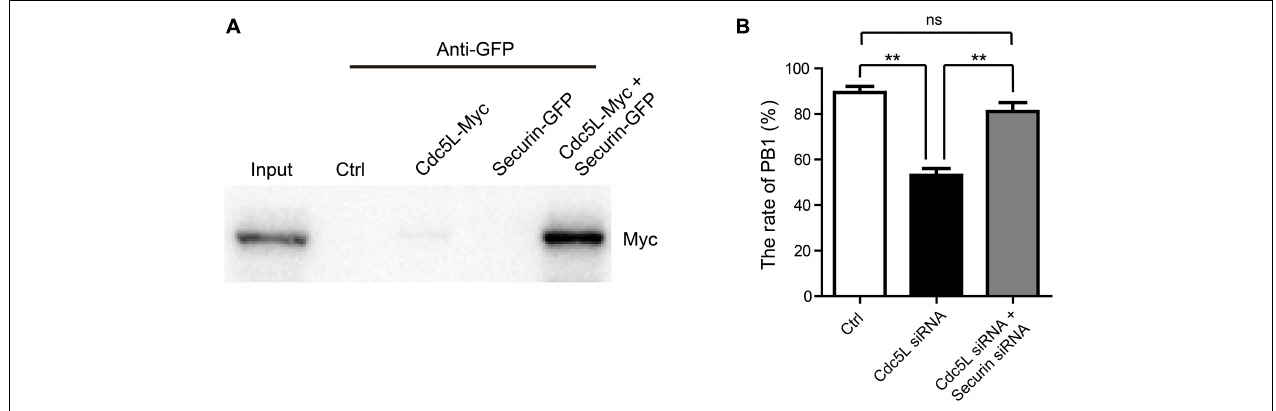
FIGURE 6 | Cdc5L affects metaphase–anaphase I transition by acting through securin. (A) Representation of IP showing interaction between Cdc5L and securin. IP of EGFP-securin was performed with anti-GFP antibody, and precipitates were analyzed by Western blot using an anti-Myc antibody. Myc-Cdc5L and EGFP-securin were co-expressed in 293T cells (lane 5). Wild-type 293T cells (lane 2), 293T cells expressing Myc-Cdc5L alone (lane 3), and 293T cells expressing EGFP-securin alone (lane 4) were used as controls. Proteins of cells co-expressing Myc-Cdc5L and EGFP-securin were loaded as an input (lane 1). (B) Rate of PB1 extrusion was rescued by securin siRNA injection in Cdc5L knockdown oocytes. Ctrl, control siRNA injected ( n = 86). Cdc5L siRNA, Cdc5L siRNA injected ( n = 74). Cdc5L siRNA and securin siRNA, Cdc5L siRNA and securin siRNA co-injected ( n = 77). Data are shown as means ± SEM. “*” represents P < 0.05; “**” represents P < 0.01. At least three replications were